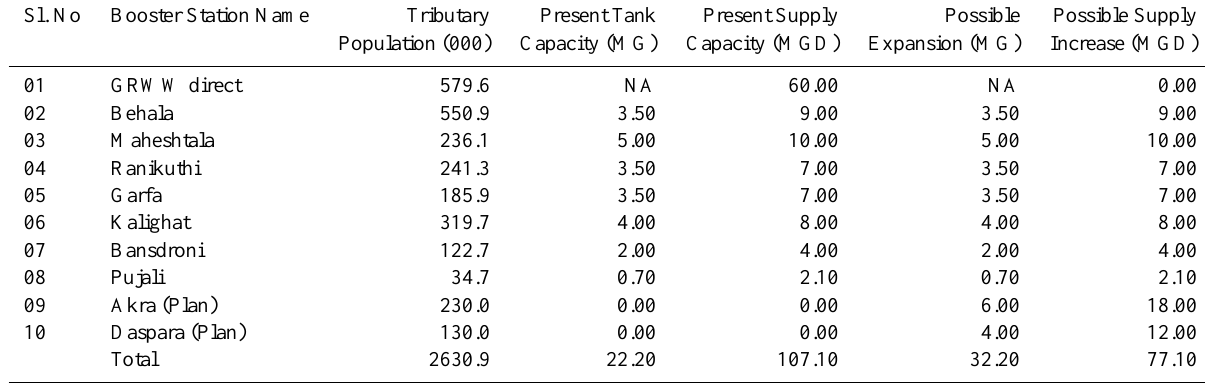
Table 1. Water supply network details.